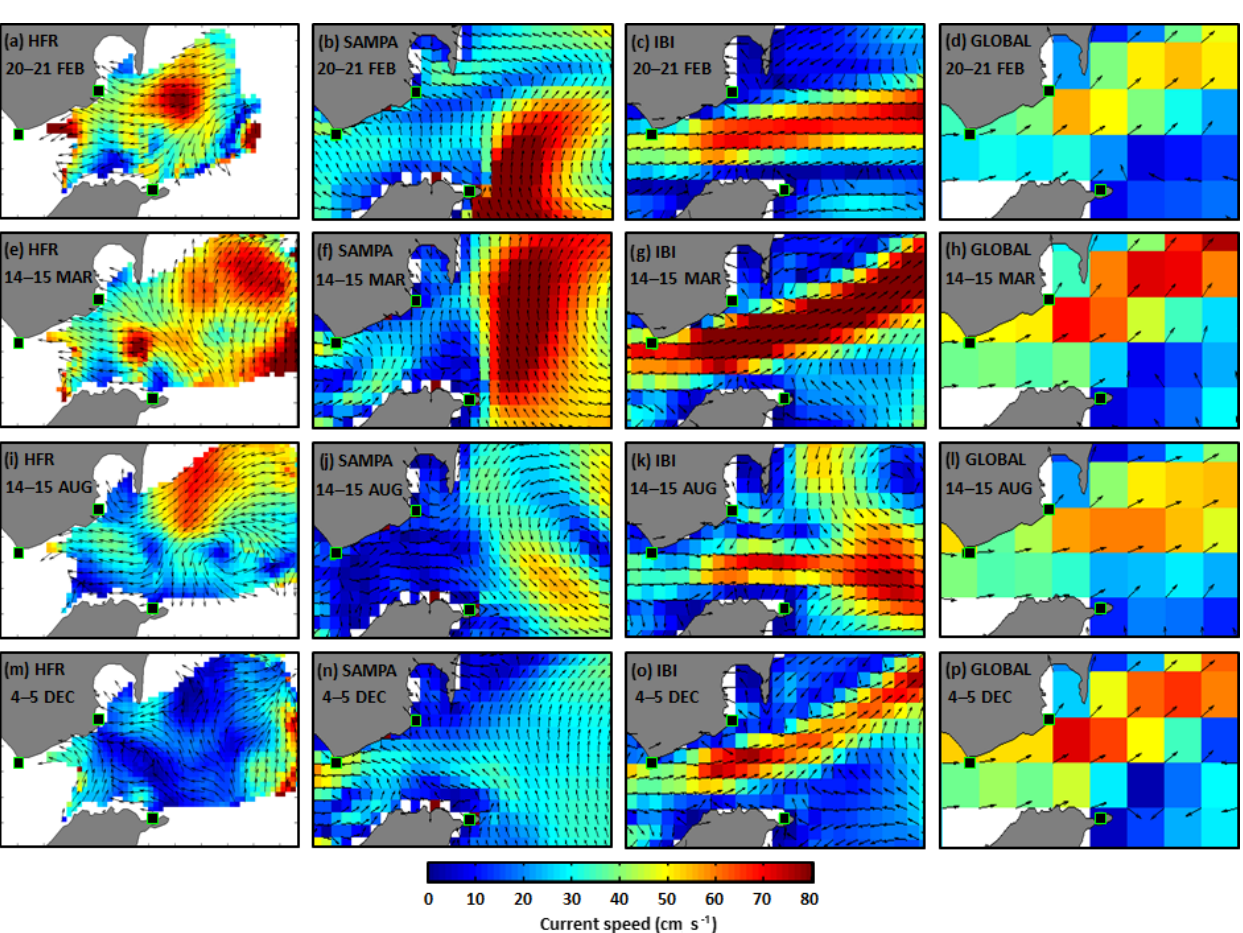
Figure 11. Two-day averaged maps of the surface circulation in GIBST, corresponding to each of the four Atlantic inflow reversal events detected in 2017 (from top to bottom). Maps derived from hourly estimations were provided by (from left to right): HFR, SAMPA coastal model, IBI regional model, and GLOBAL model. For the sake of clarity, only one vector for every two was plotted in the HFR